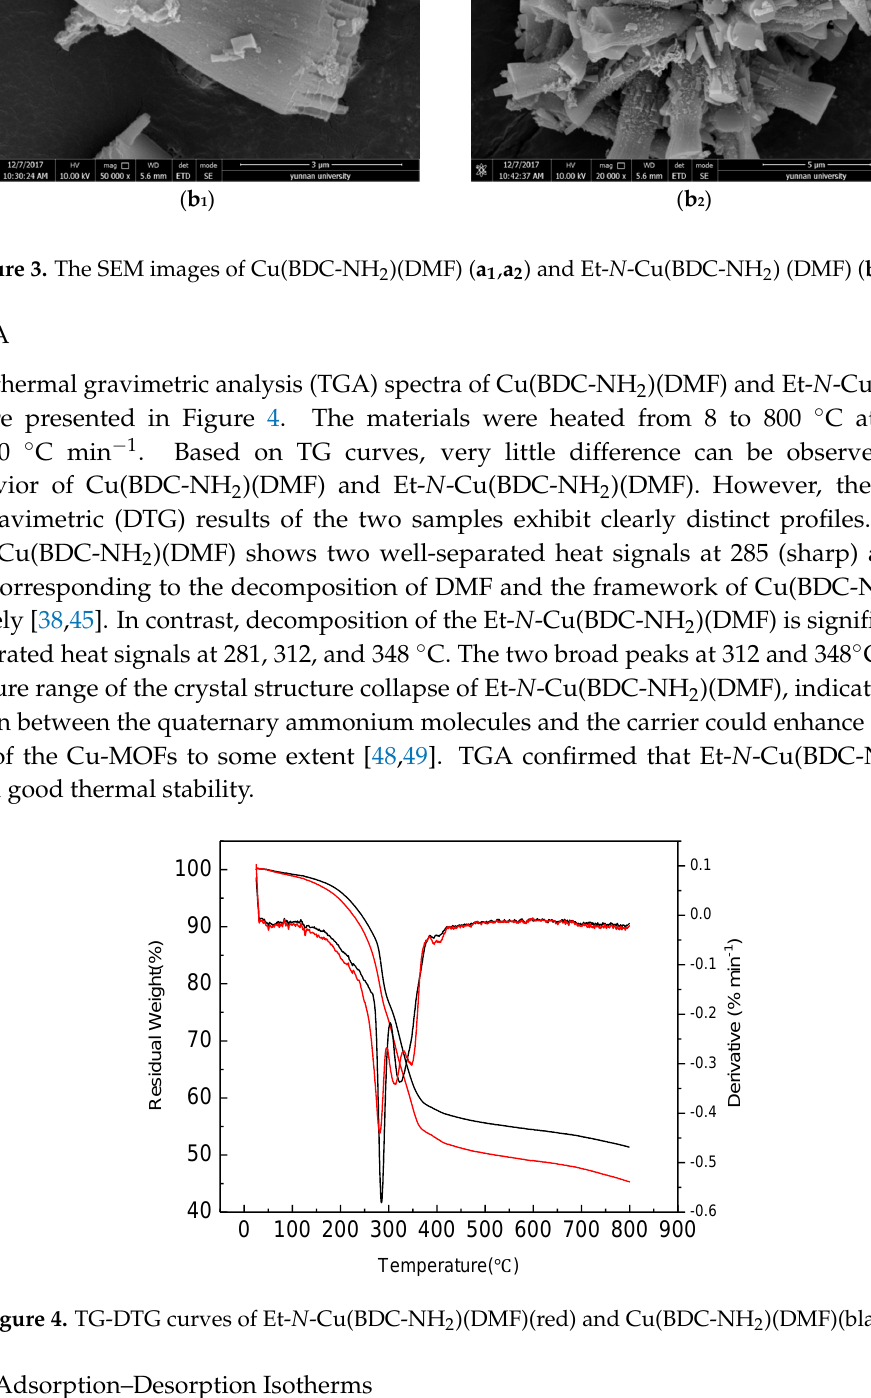
Figure 4. TG-DTG curves of Et- N -Cu(BDC-NH 2 )(DMF)(red) and Cu(BDC-NH 2 )(DMF)(black).